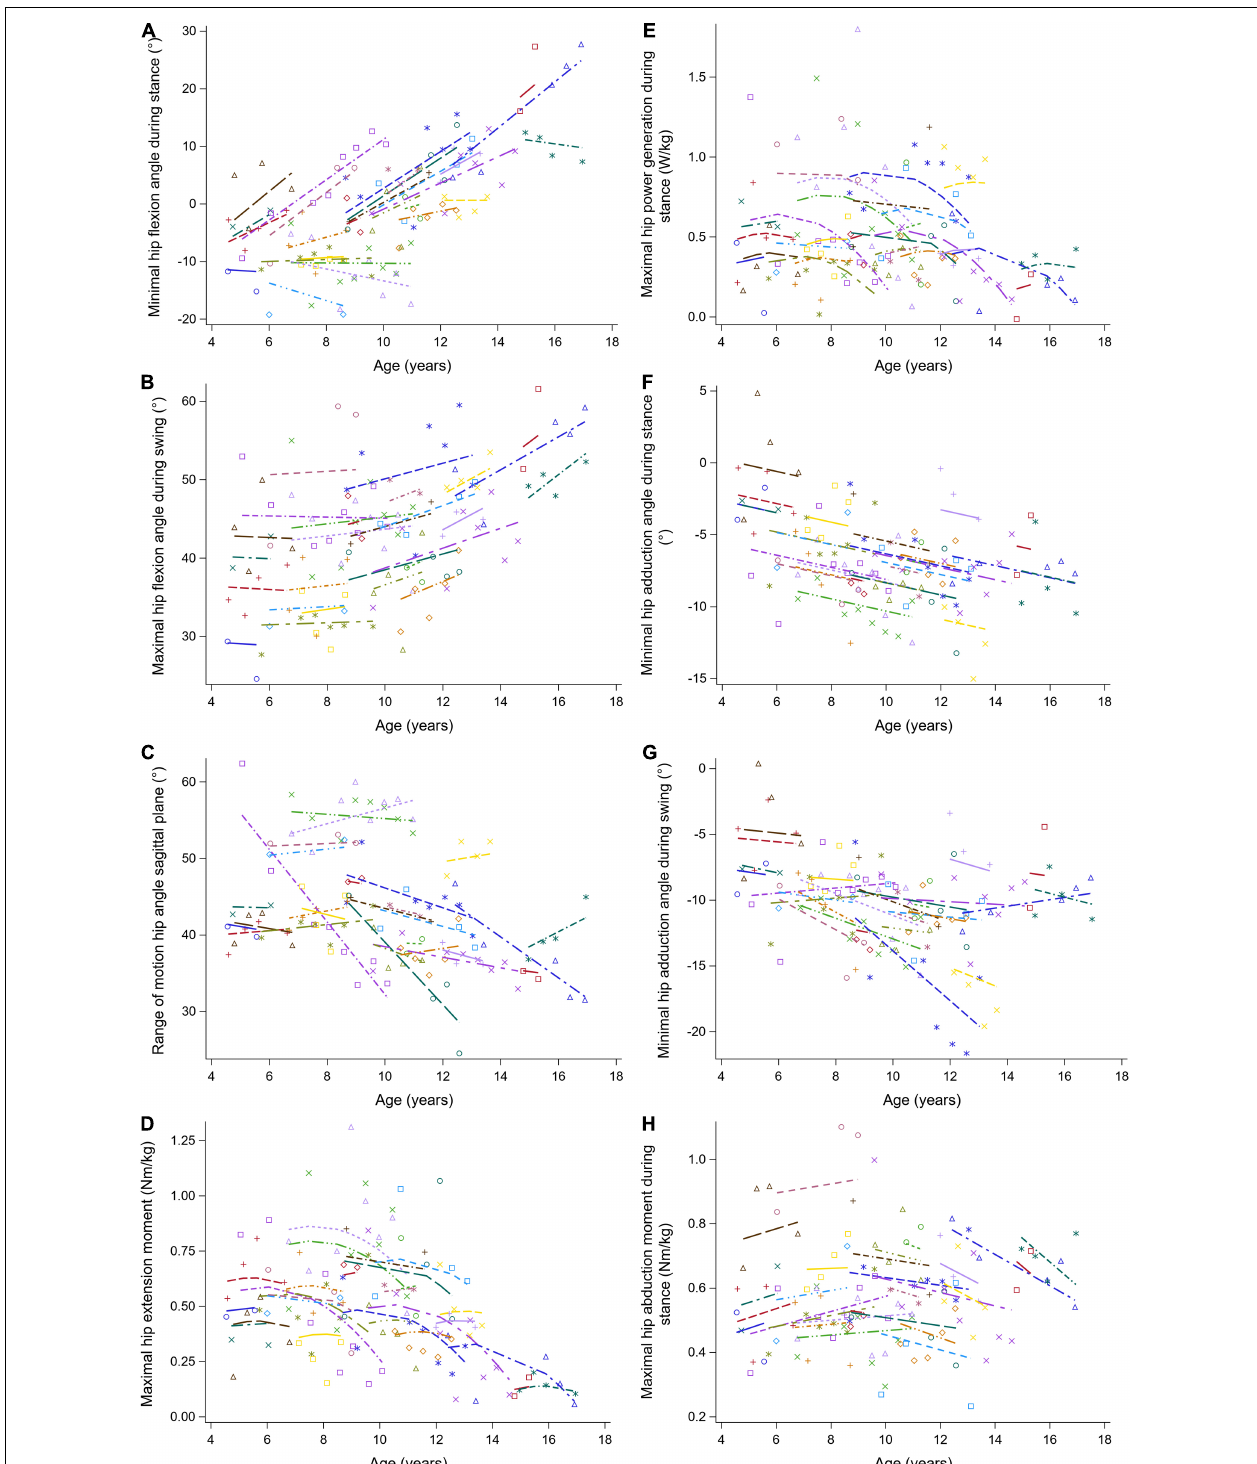
FIGURE 5 | The individual predicted profiles (dashed lines) for the minimal hip flexion angle during stance (A) , maximal hip flexion angle during swing (B) , range of hip motion in the sagittal plane (C) , maximal hip extension moment (D) , maximal hip power generation during stance (E) , minimal hip adduction angle during stance (F) , minimal hip adduction angle during swing (G) , and maximal hip abduction moment during stance (H) . The actual observed values are visualized by the symbols. Each color represents one patient with DMD. The regression coefficients of the fixed effects are given in Table 5 . DMD, Duchenne muscular dystrophy.